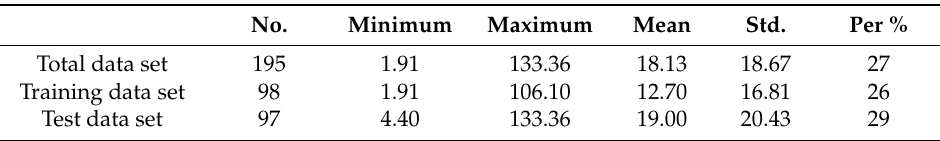
Table 3. Statistical descriptions for the arsenic contents (mg · kg − 1 ) and the percent value of contaminated samples (per %) 1